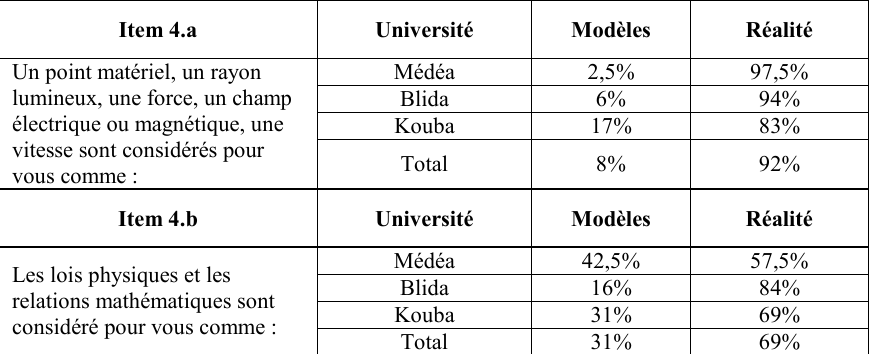
Table 6. Résultats des items 4.a et 4.b : La différenciation entre modèle et réalité Item 4.a